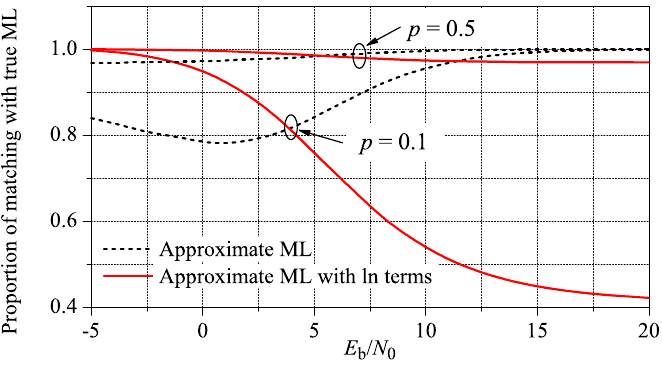
Figure 7. Proportion of matching between the true ML decisions and the approximate ML decisions with (solid) and without (dashed) correction for the low E